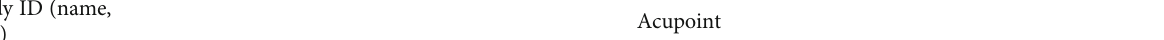
Table 4: Acupoint control